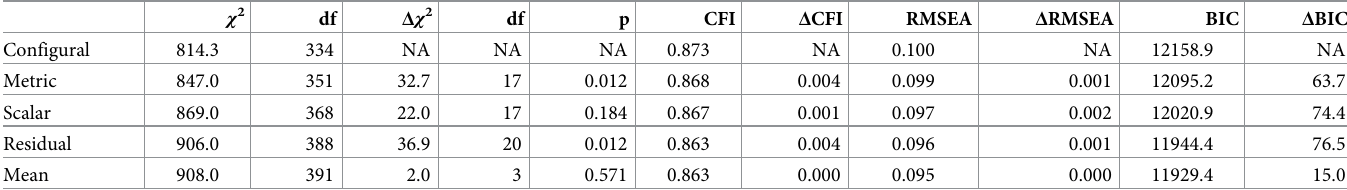
Table 4. Measurement invariance summary: Sample 2 (older adults, n =